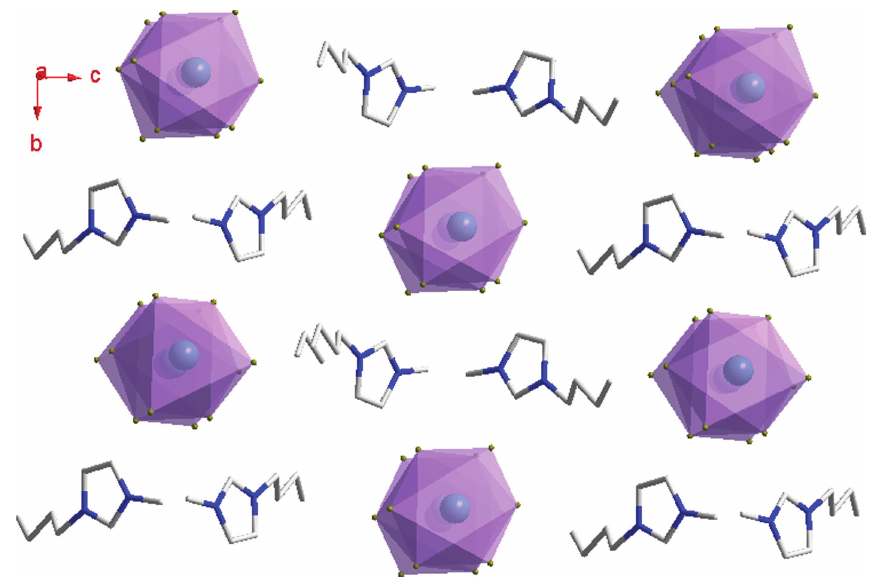
Figure 2: View along the polymeric PbC 3 − chains with a view along [¯100]. Cations fill the space between the almost hexagonally stacked anionic